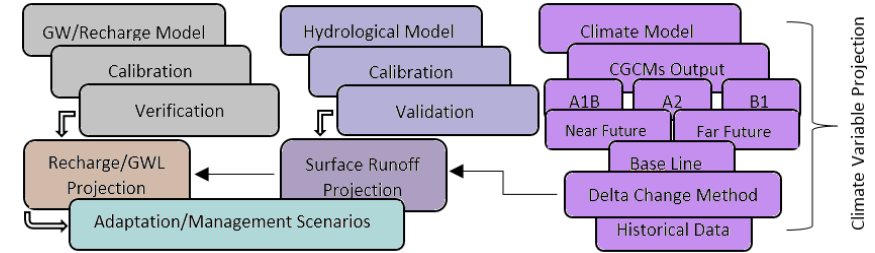
Figure 4. Flow chart showing the methodology used in this study to project climate change impacts on surface water and groundwater recharge/level.